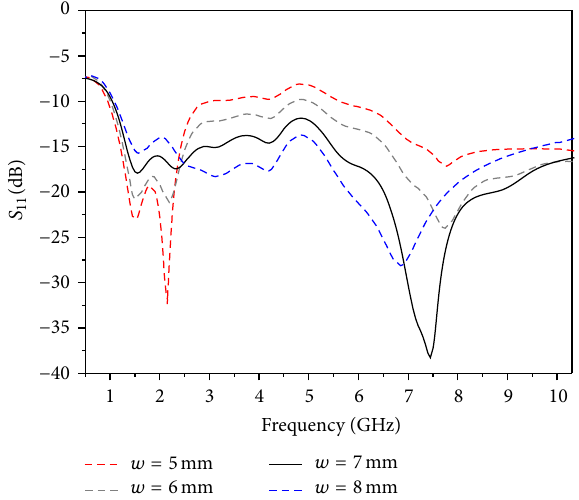
Figure 4: The different return loss between the arc surface loading or not.